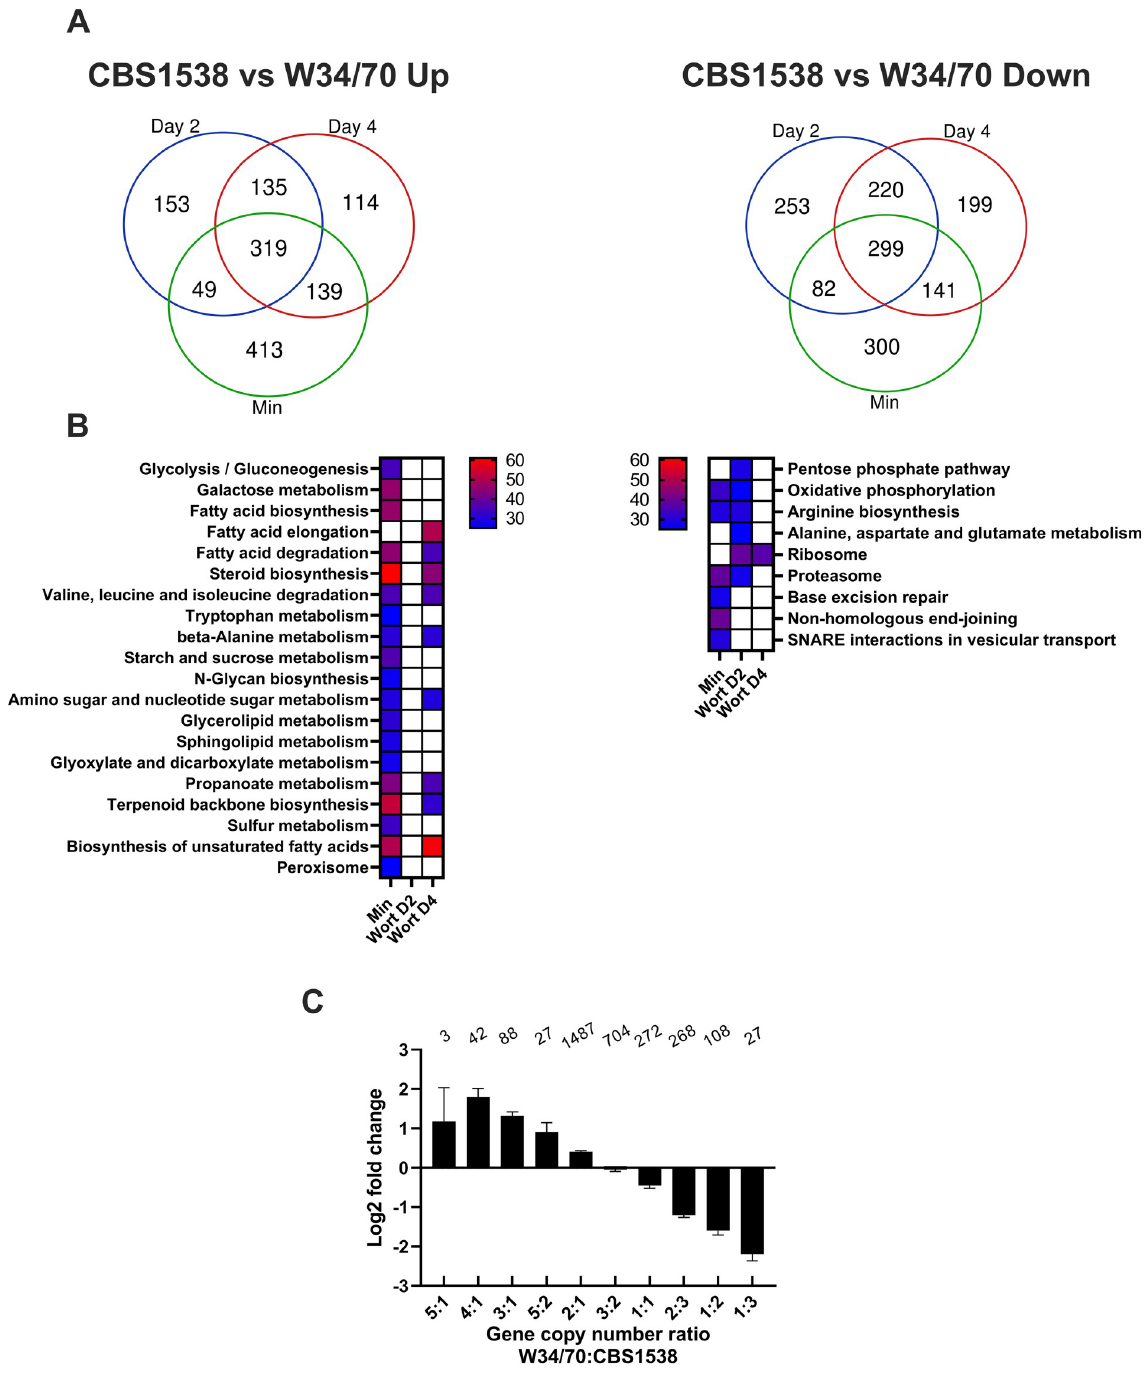
Fig 6. Comparison of gene expression in CBS1538 and W34/70 strains. Transcript reads for Sc and Se alleles were summed in CBS1538 and W34/70 respectively to create a combined transcriptome. Gene expression profiles in the three conditions, growth in minimal medium, in wort on Day 2 and in wort on Day 4 were compared between the two strains. A. Venn diagram of genes upregulated in the CBS1538 and W34/70 strains. B. Gene ontologies (GOs) enriched in the CBS1538 and W34/70 strains respectively. Left panel, GOs upregulated in CBS1538, right panel, GOs upregulated in W34/70. The parameters for selection of GO terms were as follows: p-value less than 0.05, minimum number of four genes per pathway, pathways containing more than 25% of the genes differentially regulated. Heat map shows the percentage of genes associated with each GO term: gradient blue to red, where blue represents a minimum of 25% of associated genes and red represents a maximum of 60% of associated genes. C. Relationship of gene copy number and gene expression in W34/70 and CBS1538. The ratio of the gene copy number for the sum of all alleles (Sc+Se) was compared to Log 2 fold differences in gene expression in W34/70 and CBS1538. The number of genes in each ratio category is shown above the bars. Data for Day 2 in wort is shown. Data for Day 4 and minimal medium are shown in the S3 Fig.